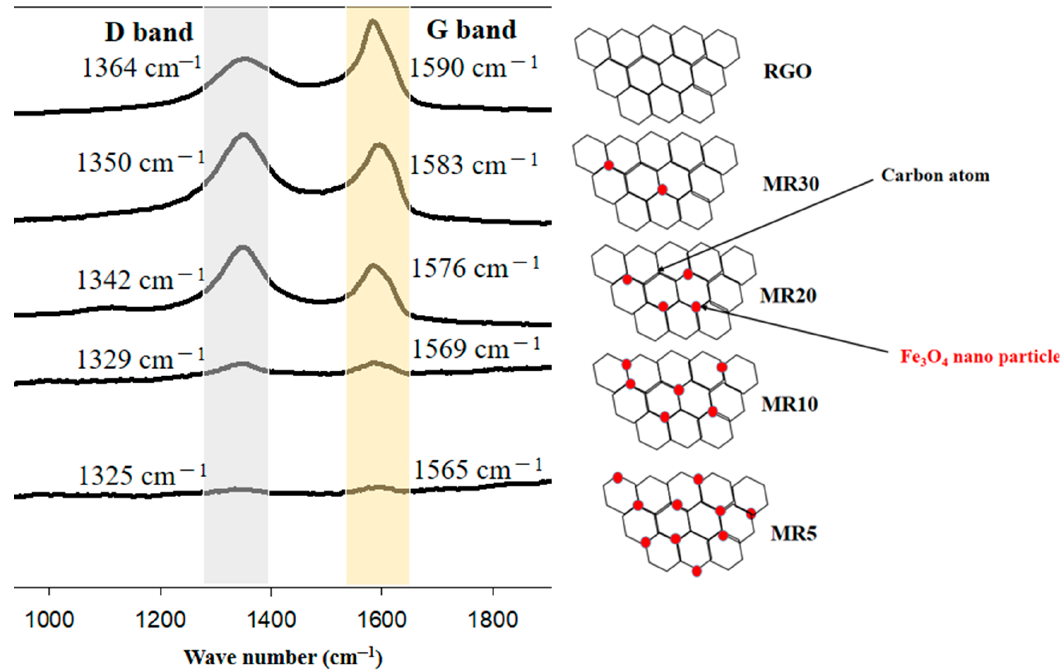
Figure 4. The interaction between rGO and Fe 3 O 4 according to the Raman results.